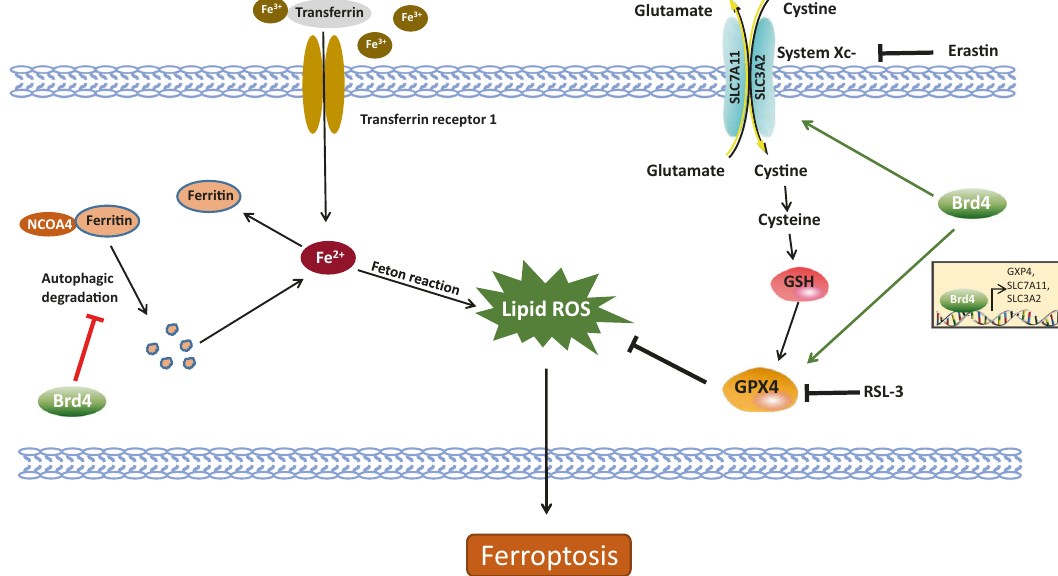
Fig. 5 Roles of Brd4 in ferroptosis. Brd4 suppresses ferroptosis by transcriptionally promoting the expression of GAP4, SLC7A11 and SLC3A2 and inhibiting the autophagic degradation of